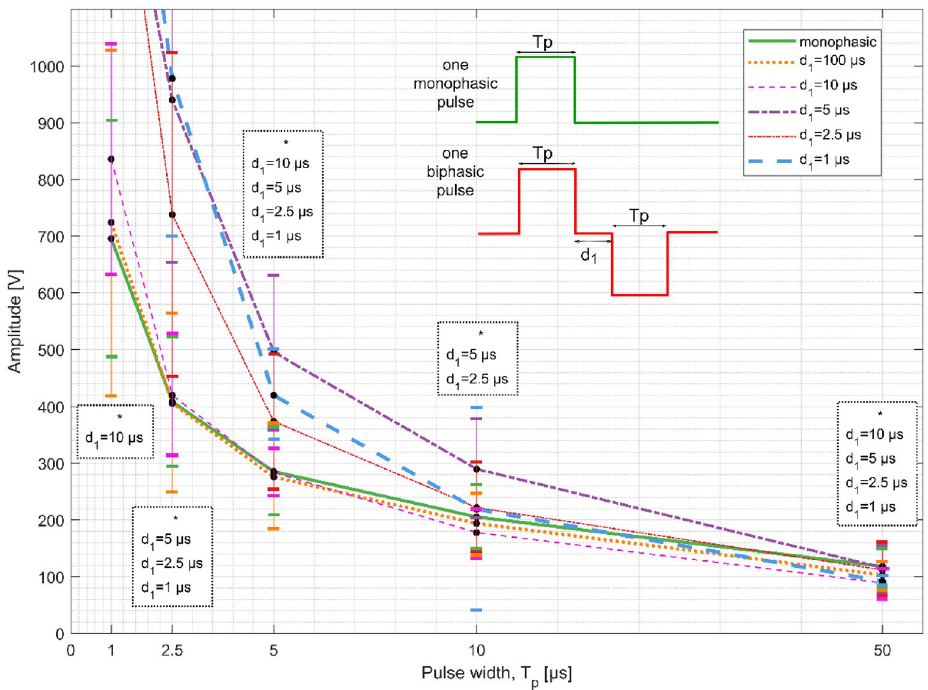
Figure 2. Threshold amplitude as a function of the pulse width for single monophasic (solid green curve) and biphasic pulses (Strength–Duration curves). Biphasic pulses are shown for each interphase delay from 1 µs to 100 µs. The results are shown as mean amplitude of the individuals (black dots) ± standard error (vertical bars). The boxes with asterisks (*) and interphase delays show statistically significant differences between the monophasic pulse and marked interphase delay (biphasic pulse) for each pulse width tested (statistically higher mean values for the biphasic pulses for all pulse widths tested except for T p = 50 µs). Note that for pulse width of 1 µs, paired t-test was performed only for d 1 = 10 µs and 100 µs, as the threshold amplitude was higher than 1000 V for the rest of the interphase